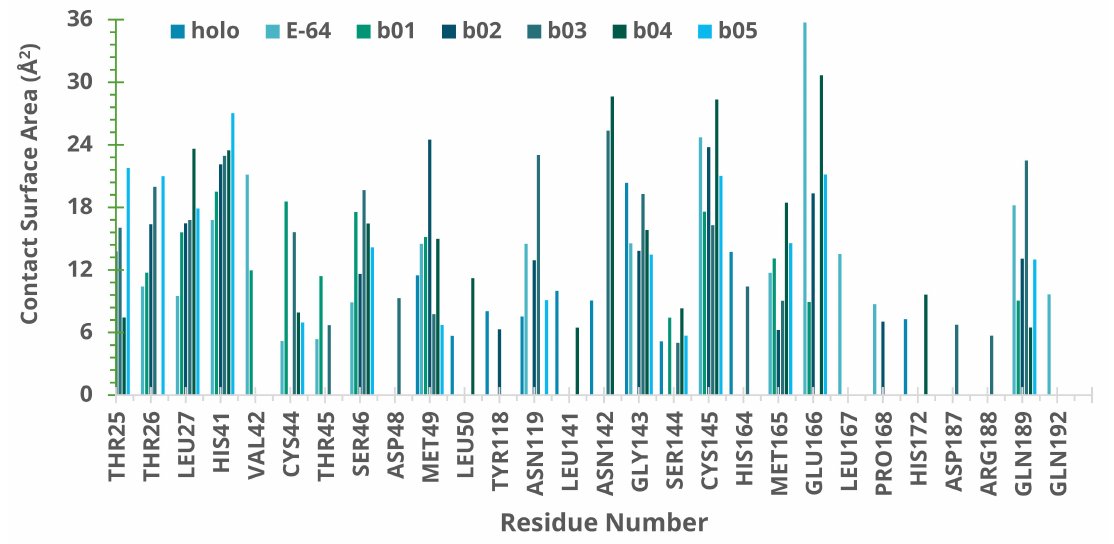
Figure 5. Surface molecular area (Å2) of SARS-CoV-2 Mpro complexes as calculated by SurfinMD after 100 ns of molecular dynamics